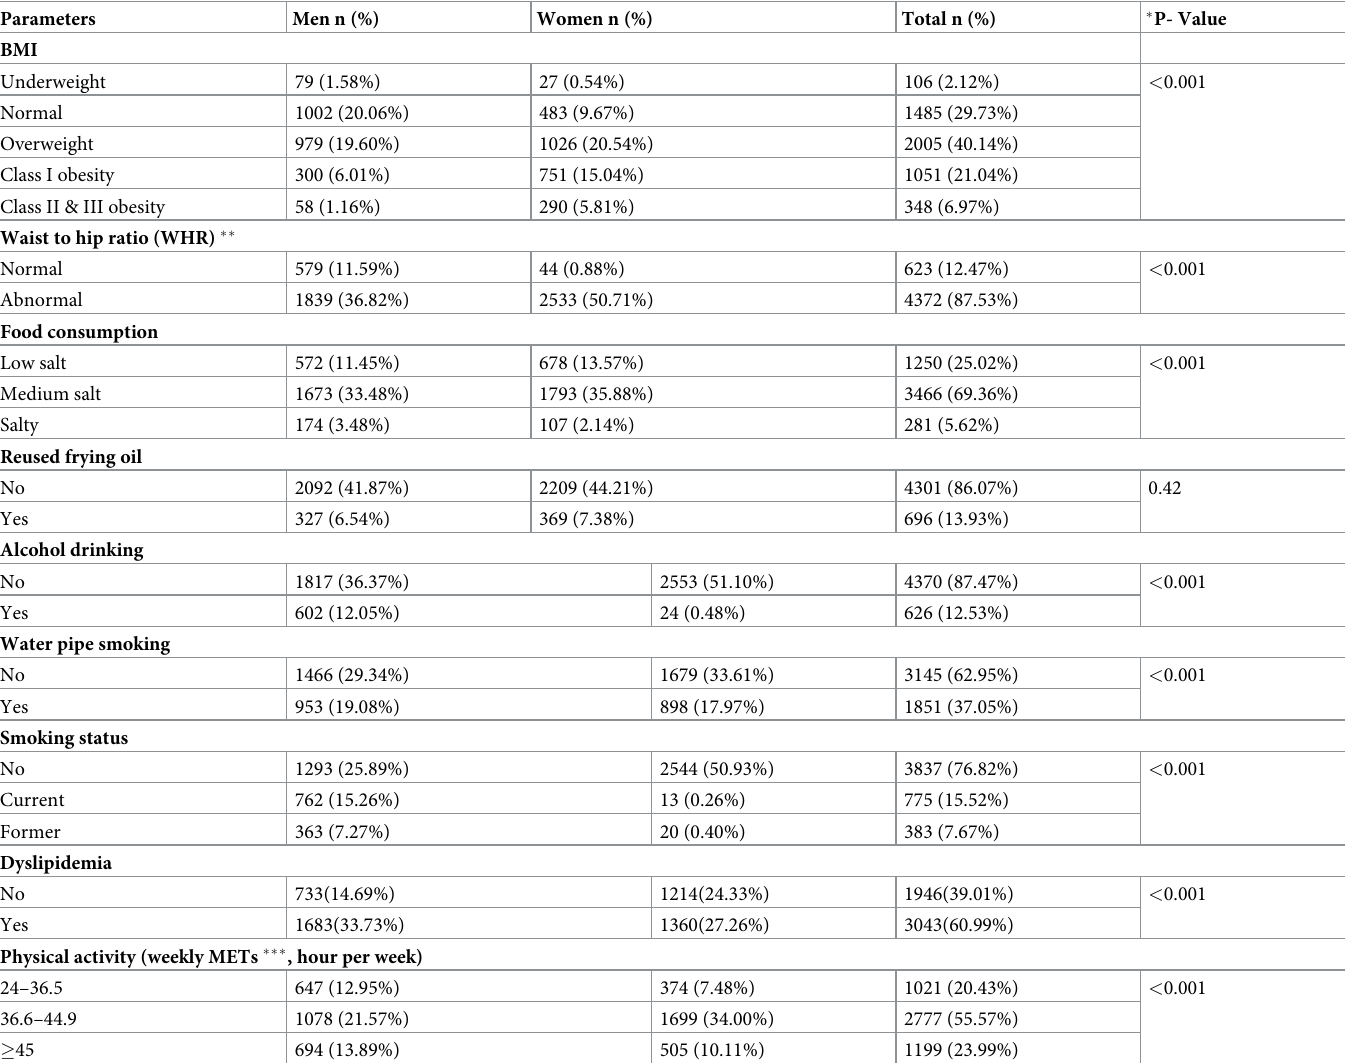
Table 3. The frequency of anthropometric indices and lifestyle